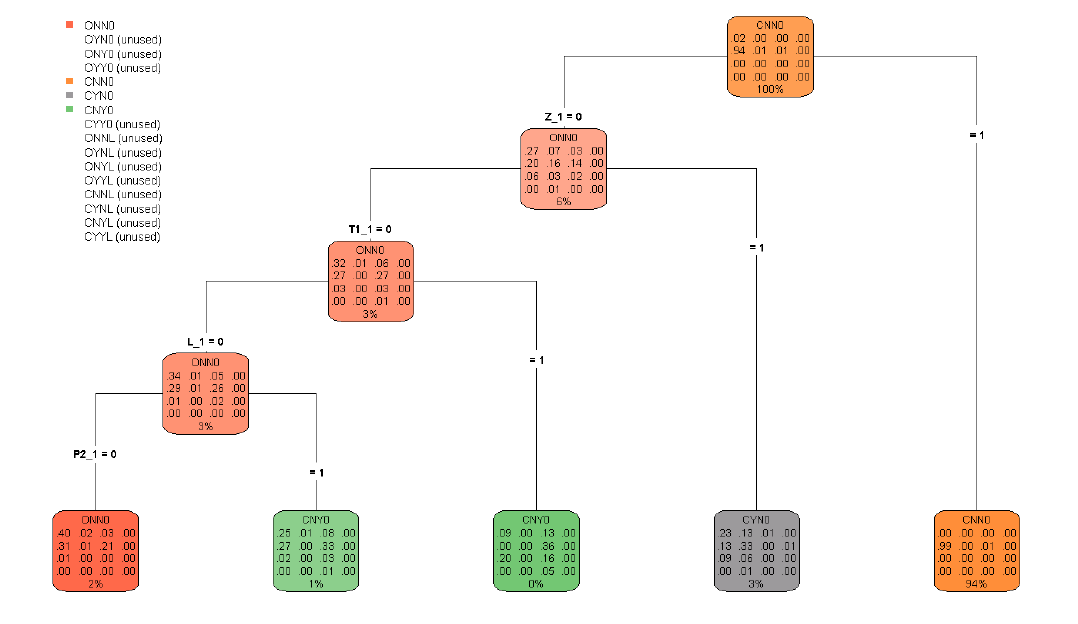
Figure 1. Frequency model: pruned classification tree for lag (cid:96) =